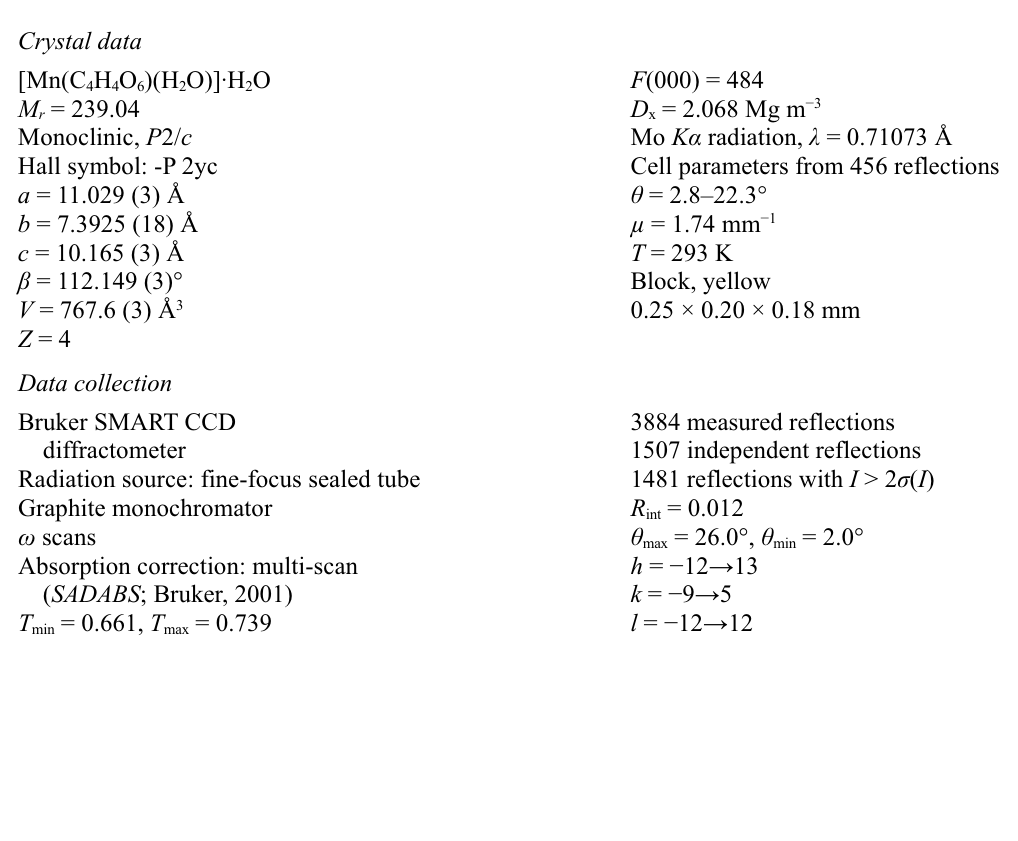
Figure 2 View of the layered network in (I) along [010] direction, with the A and B rings indicated (see text). Poly[[diaqua- µ -tartrato- µ -tartrato-dimanganese(II)] 4 2